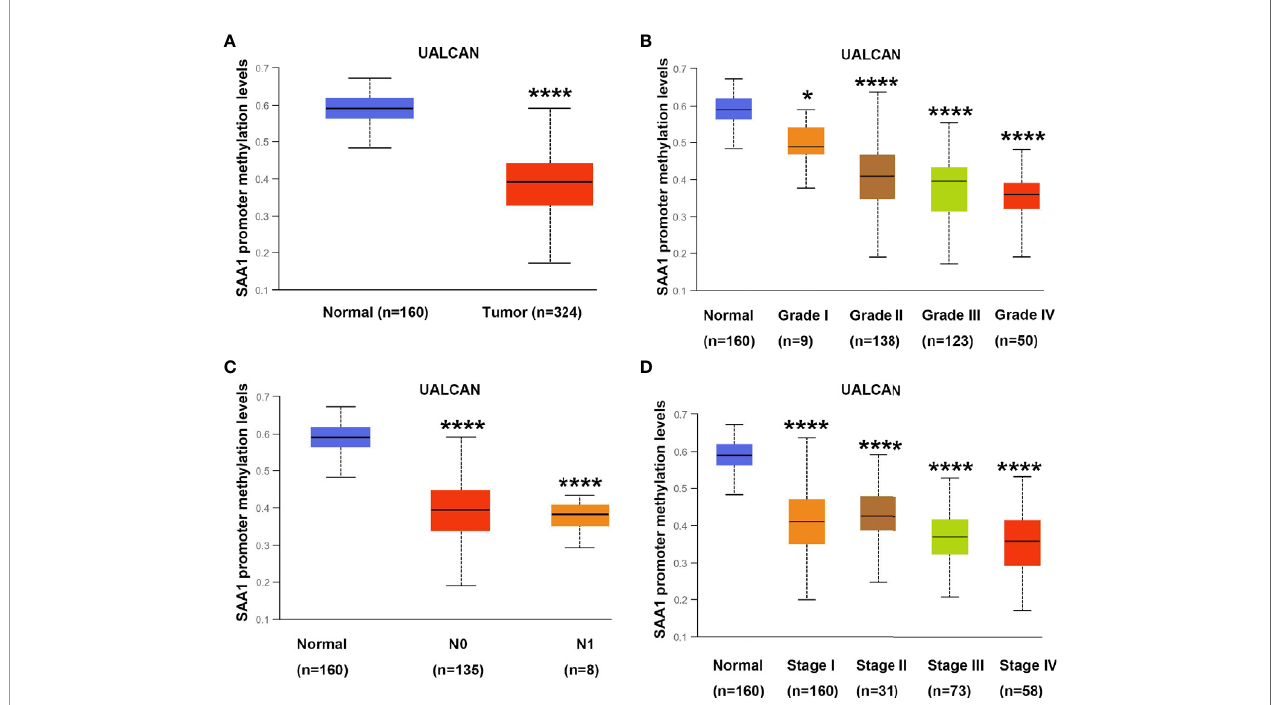
FIGURE 5 | Analysis of methylation levels in SAA1 gene promoter region. (A) The methylation analysis of SAA1 gene promoter region in ccRCC samples from UALCAN database. (B) The methylation levels of SAA1 gene promoter region were compared in tumor grade from UALCAN database. (C) The methylation levels of SAA1 gene promoter region were compared in N stage from UALCAN database. (D) The methylation levels of SAA1 gene promoter region were compared in TNM stage from UALCAN database. (****P<0.0001, *P<0.05, compared with the respective